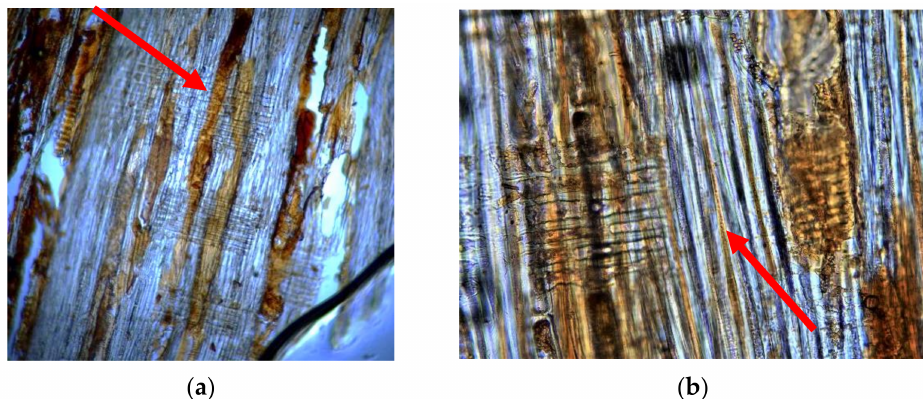
Figure 3. Beech ( Fagus sylvatica ) wood impregnated with 10% of tannin solution. ( a ) Tannin solution in vessels, 100 × ; ( b ) Few narrow fiber tracheids contain a small amount of tannin solution, 400 × .